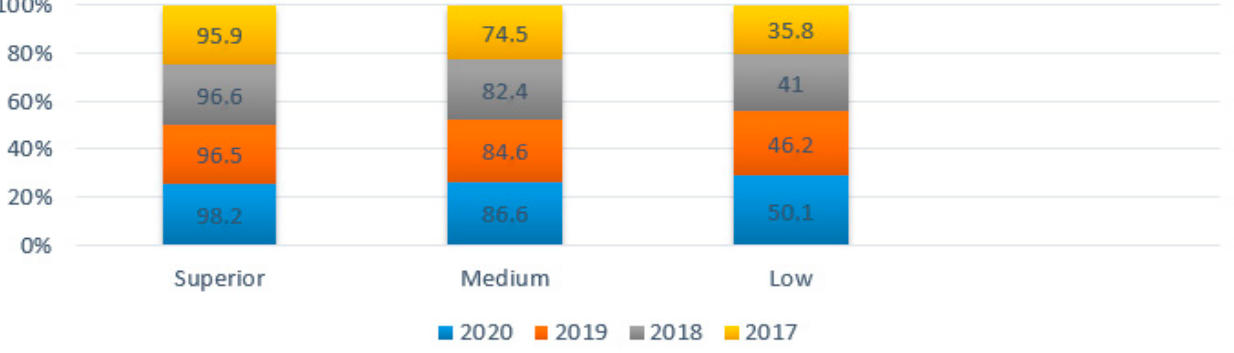
Figure 10. Internet access by the level of education